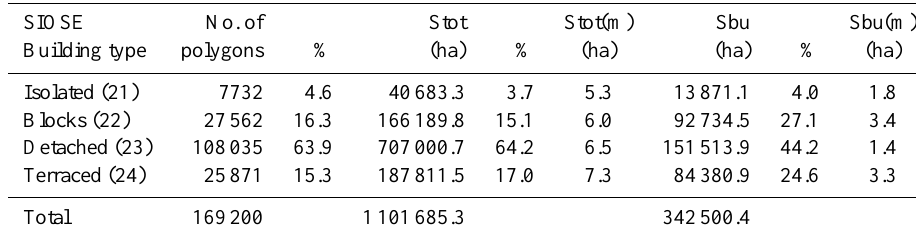
Table 3. Summary of SIOSE building and surface types for